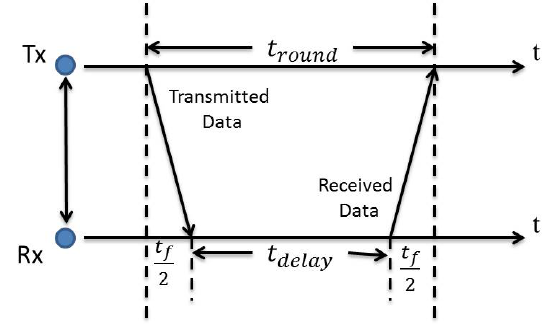
Figure 5. Principle of the two-way ToF distance